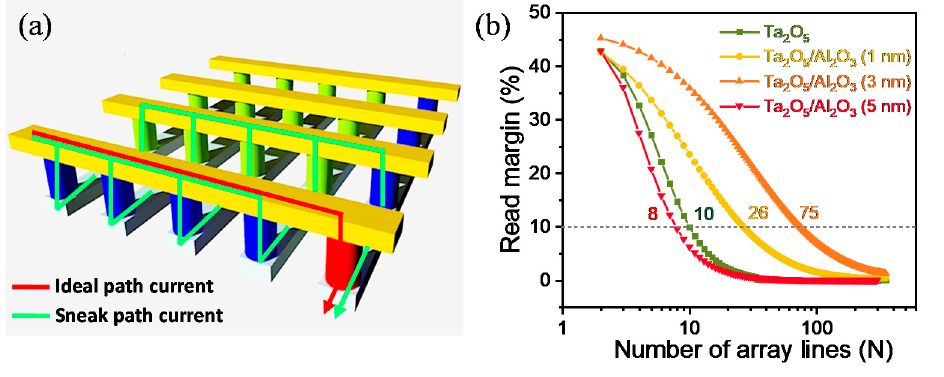
Figure 5. ( a ) Schematics of two-terminal RRAM based crossbar array configuration for high integrated application. ( b ) Calculated read margin as a function of number of array line for four devices.